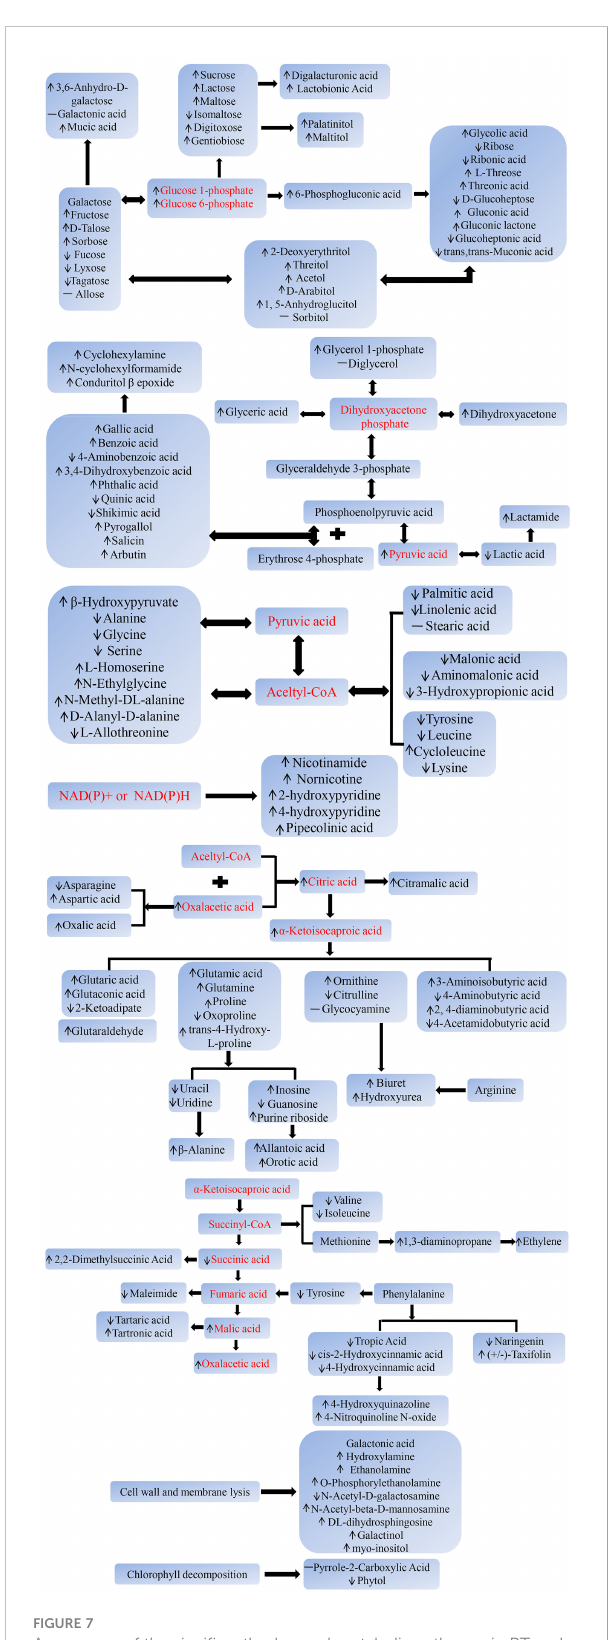
FIGURE 7 A summary of the signi fi cantly changed metabolic pathways in RT and LT storages. Narrow: upregulated or downregulated; dash: